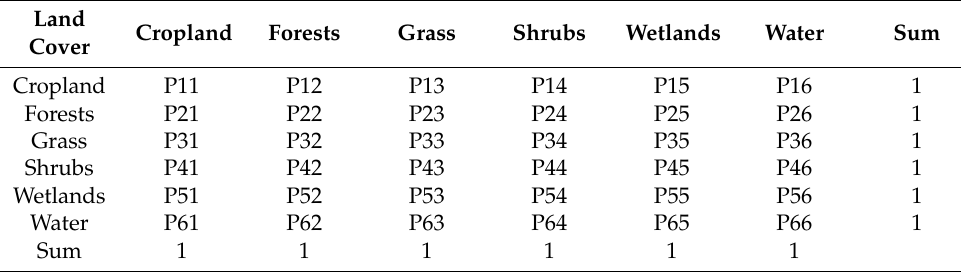
Table 4. Conversion matrix of the land cover type of each eco–geographical region. Land Cropland Forests Grass Shrubs Wetlands Water Sum Cover Cropland P11 P12 P13 P14 P15 P16 1 Forests P21 P22 P23 P24 P25 P26 1 Grass P31 P32 P33 P34 P35 P36 1 Shrubs P41 P42 P43 P44 P45 P46 1 Wetlands P51 P52 P53 P54 P55 P56 1 Water P61 P62 P63 P64 P65 P66 1 Sum 1 1 1 1 1